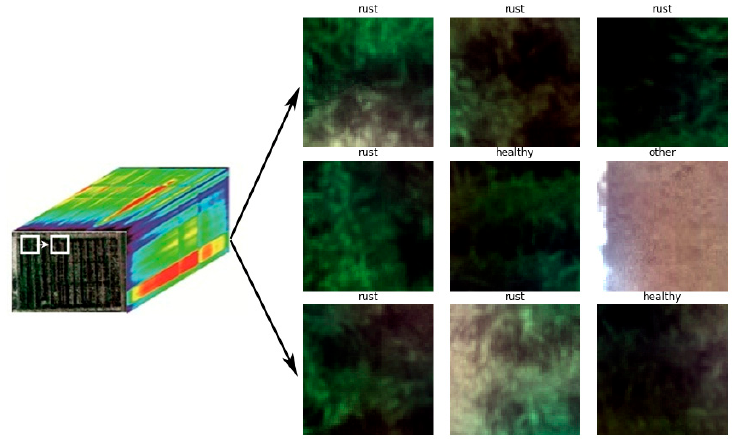
Figure 3. Schematic of image segmentation process via a sliding-window method. Each of the segmented blocks with a size of 64 × 64 × 125 was labelled as rust area, healthy area or other.